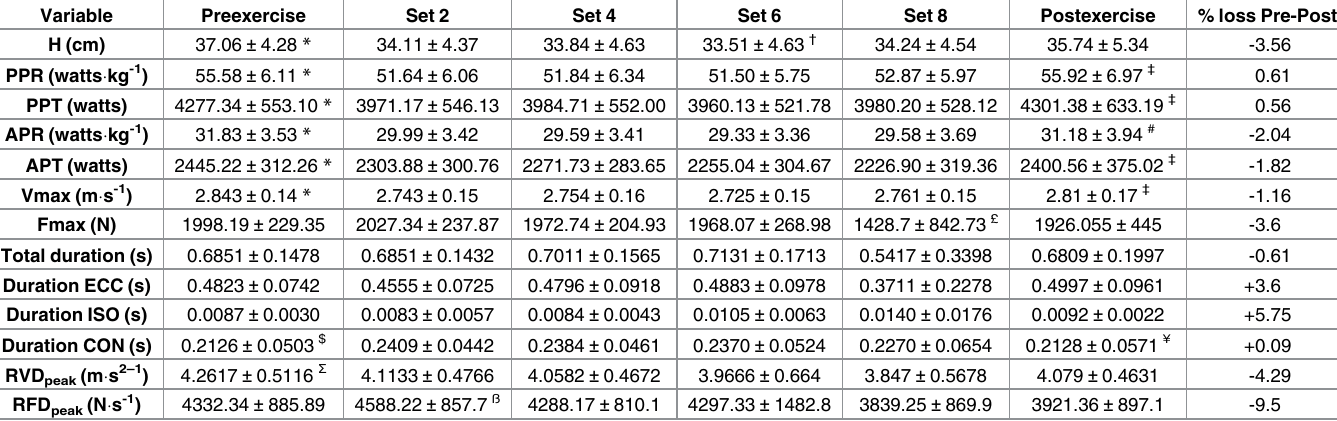
Table 5. Variables reflecting muscular fatigue recorded during the 6 sets of the metabolic conditioning WOD in the 34 study